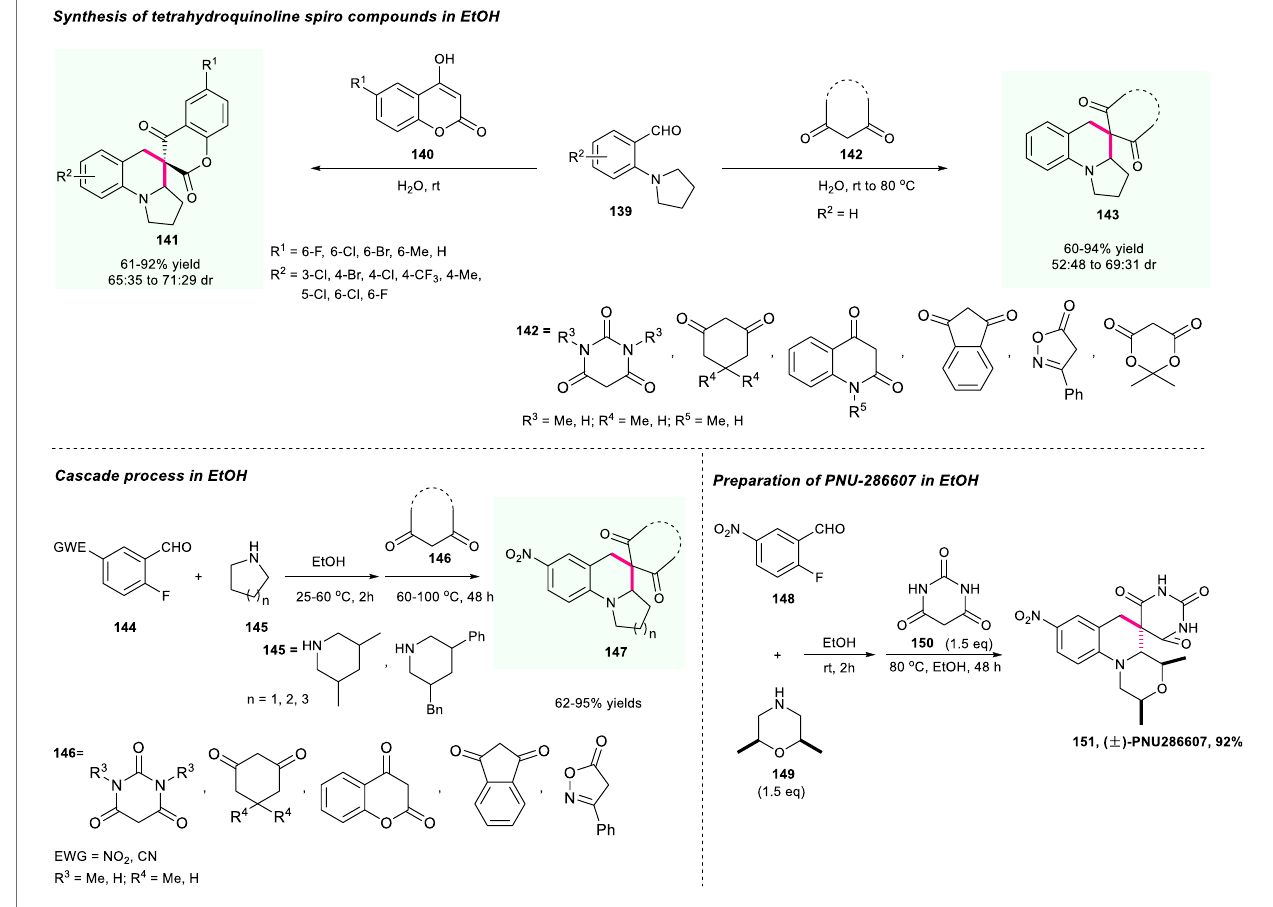
SCHEME 15 | Facile synthesis of spirocyclic tetrahydroquinolines.